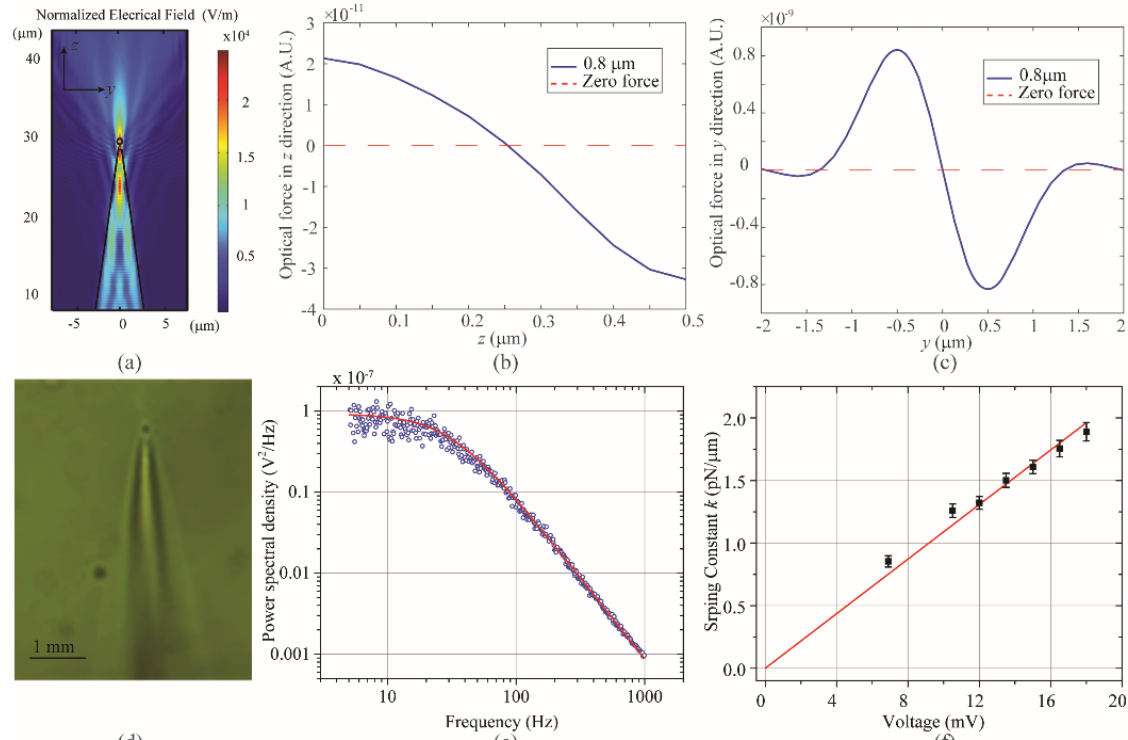
Figure 3. Numerical simulations and the experimental demonstration of the 3D trapping for a single submicron particle by a single fiber − based system. ( a ) Numerical simulation of a normalized electrical field when an 800 nm silica bead is trapped by the single etched fiber. ( b , c ) The simulated optical forces as a function of the particle position along the y - and z -axes, respectively. ( d ) The 3D optical trapping of an 800 nm silica bead by a single etched fiber is mounted at 45 − degree with a vertical axis. The 10 × objective is used in this experiment. ( e ) The PSD of the motion of the trapped particle as a function of frequency. The corner frequency is obtained by fitting the PSD to a Lorentzian. The red curve in ( e ) is the fitted Lorentzian. ( f ) The linear dependency of the calibrated spring constant on the optical power. The black data points with error bars are the experimental data and the straight red line is the fitted line passing through (0,0).